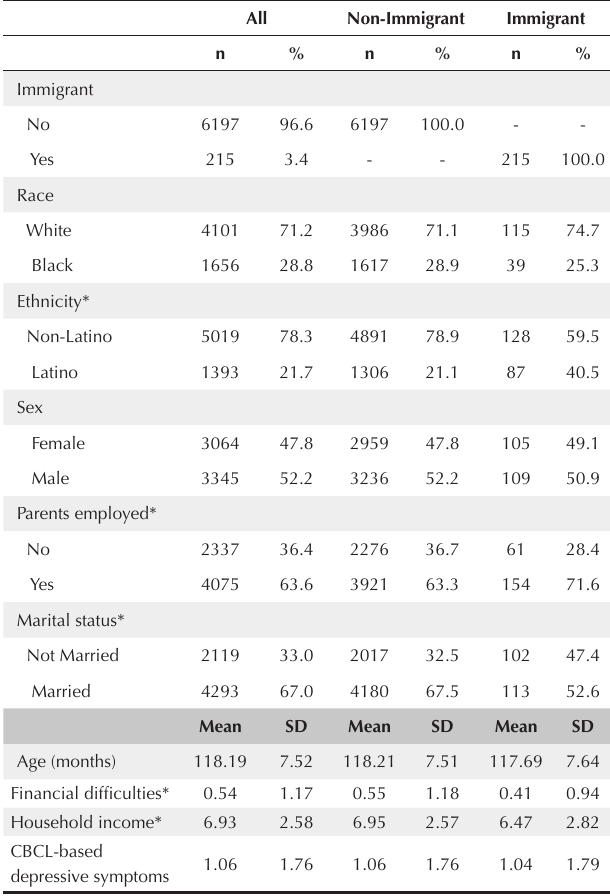
Table 1. Data Overall and by Immigration Status (n = 6412) All